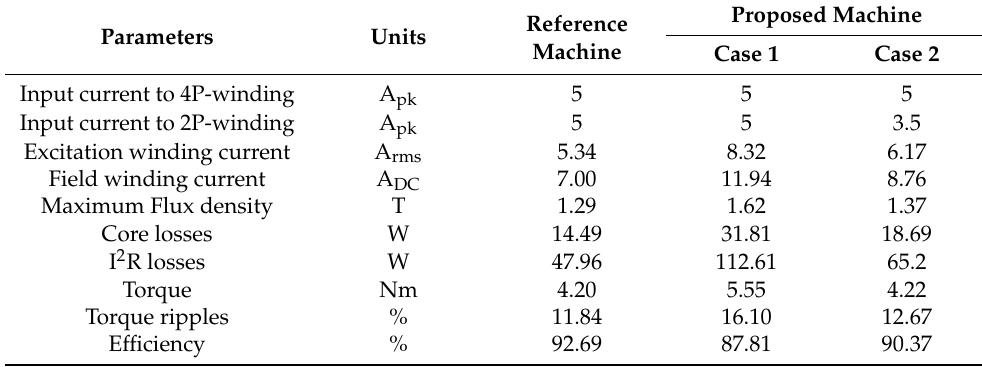
Table 2. Performance